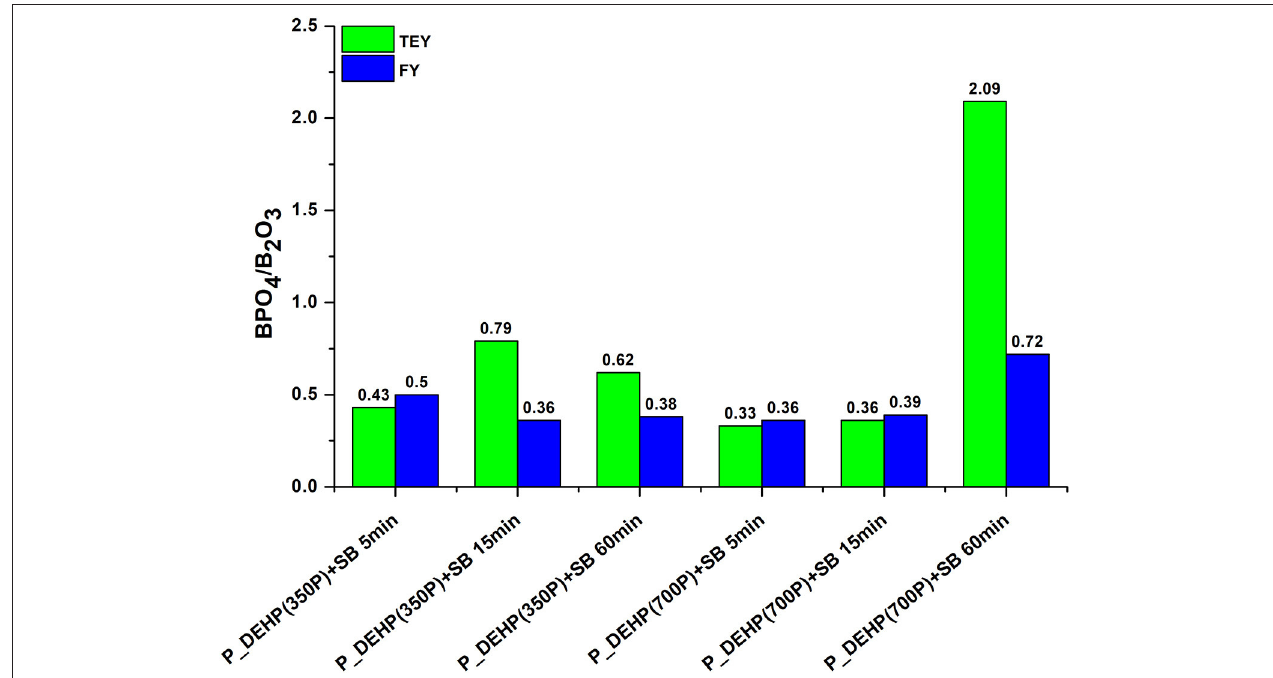
FIGURE 12 | BPO 4 /B 2 O 3 ratio measured for tribofilms formed using P_DEHP(350P) + SB and P_DEHP(700P) + SB at 5, 15, and 60min